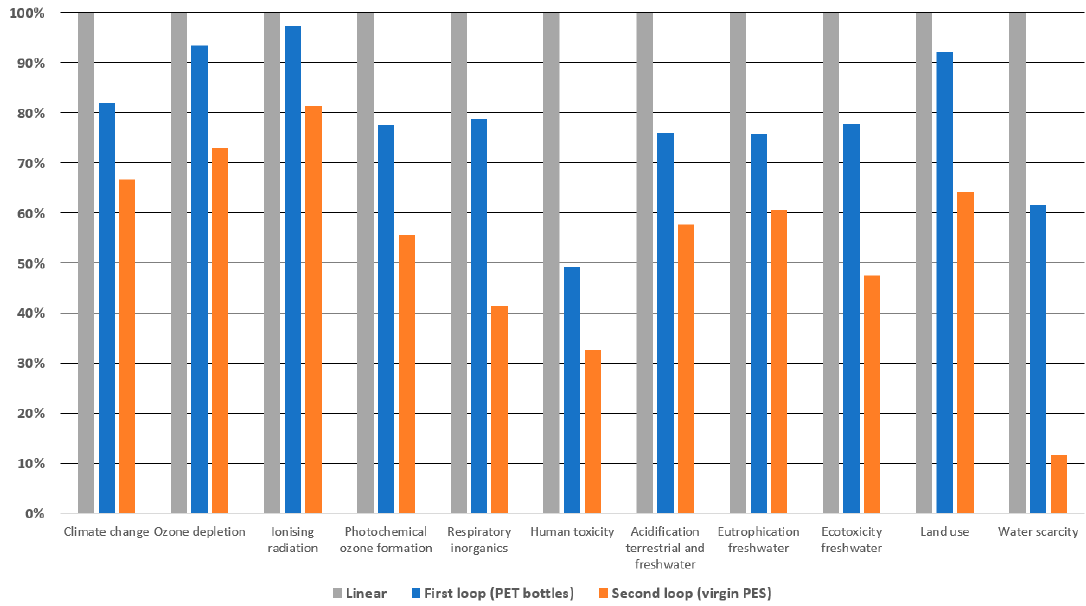
Figure 3. Environmental impact comparison between the linear product system (grey) and the first (blue) and second loop (orange) product systems.